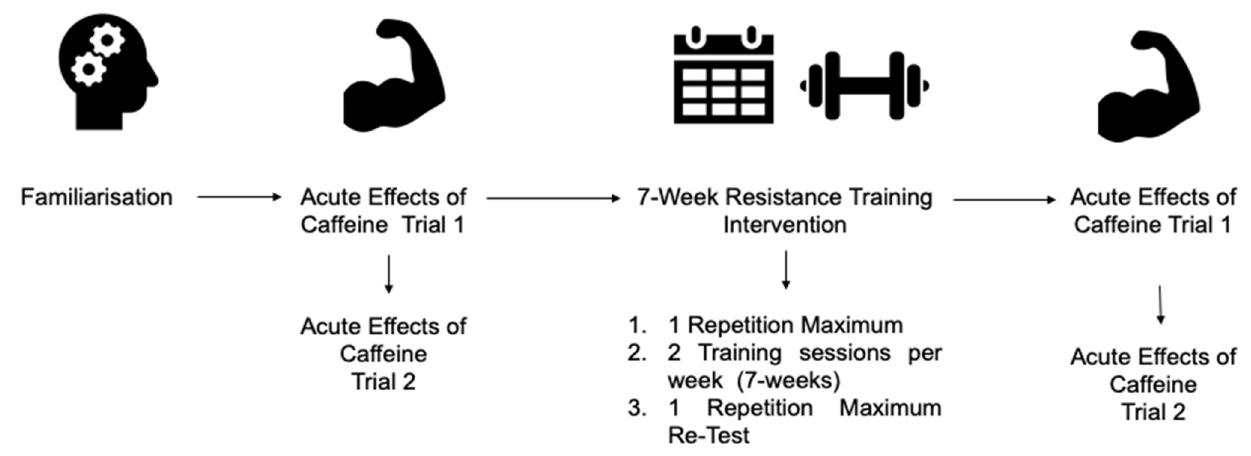
Figure 1. Schematic of experimental design.